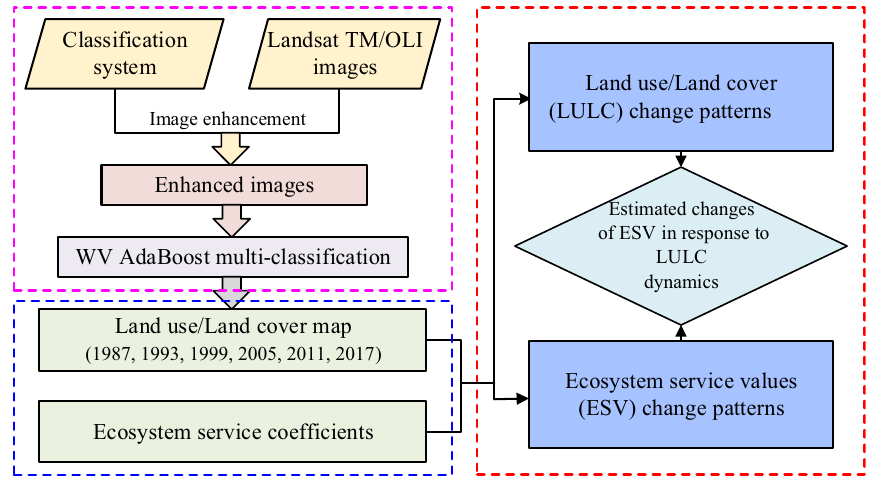
Figure 1. The framework of this paper.